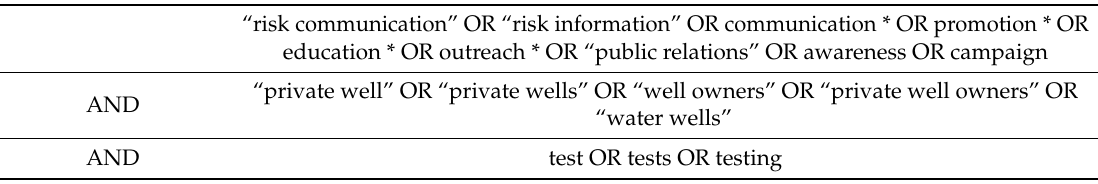
Table 1. Search terms used in the study identification